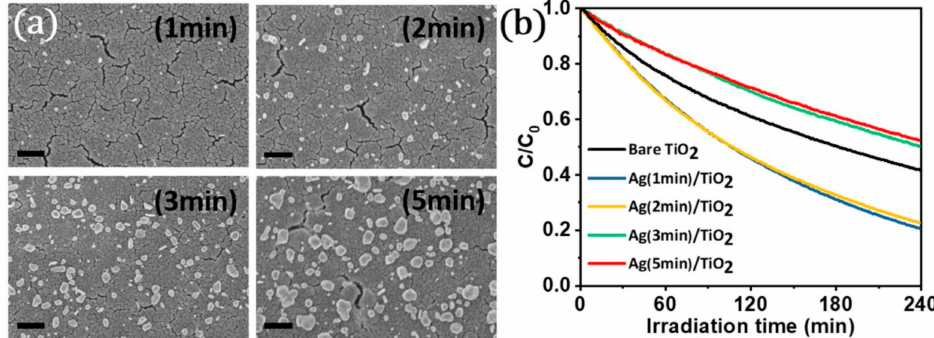
Figure 10. ( a ) SEM images (having same scale bar of 400 nm) of Ag NPs decorated TiO 2 thin film prepared at di ff erent UV exposure time intervals and ( b ) comparison of time-dependent photocatalytic performance for bare and Ag NPs decorated TiO 2 (with di ff erent surface coverages). Adapted with permission from [23]. Copyright (2019)